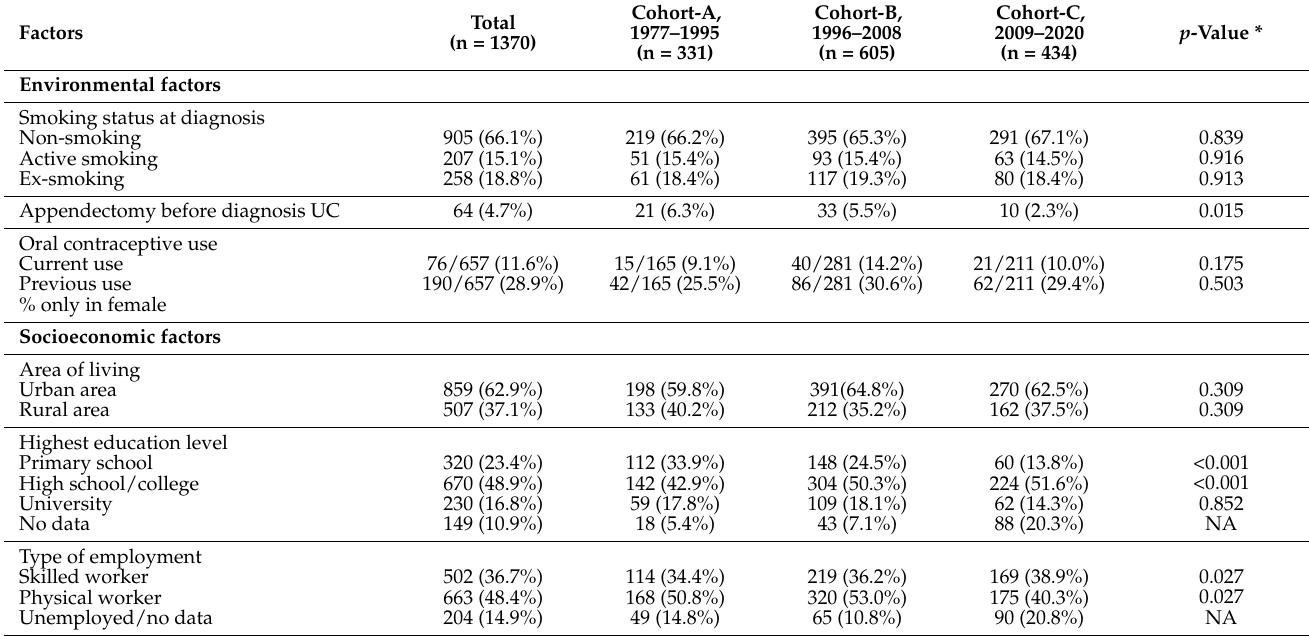
Table 2. Trend of environmental factors of 1370 incident UC patients stratified by the eras of UC